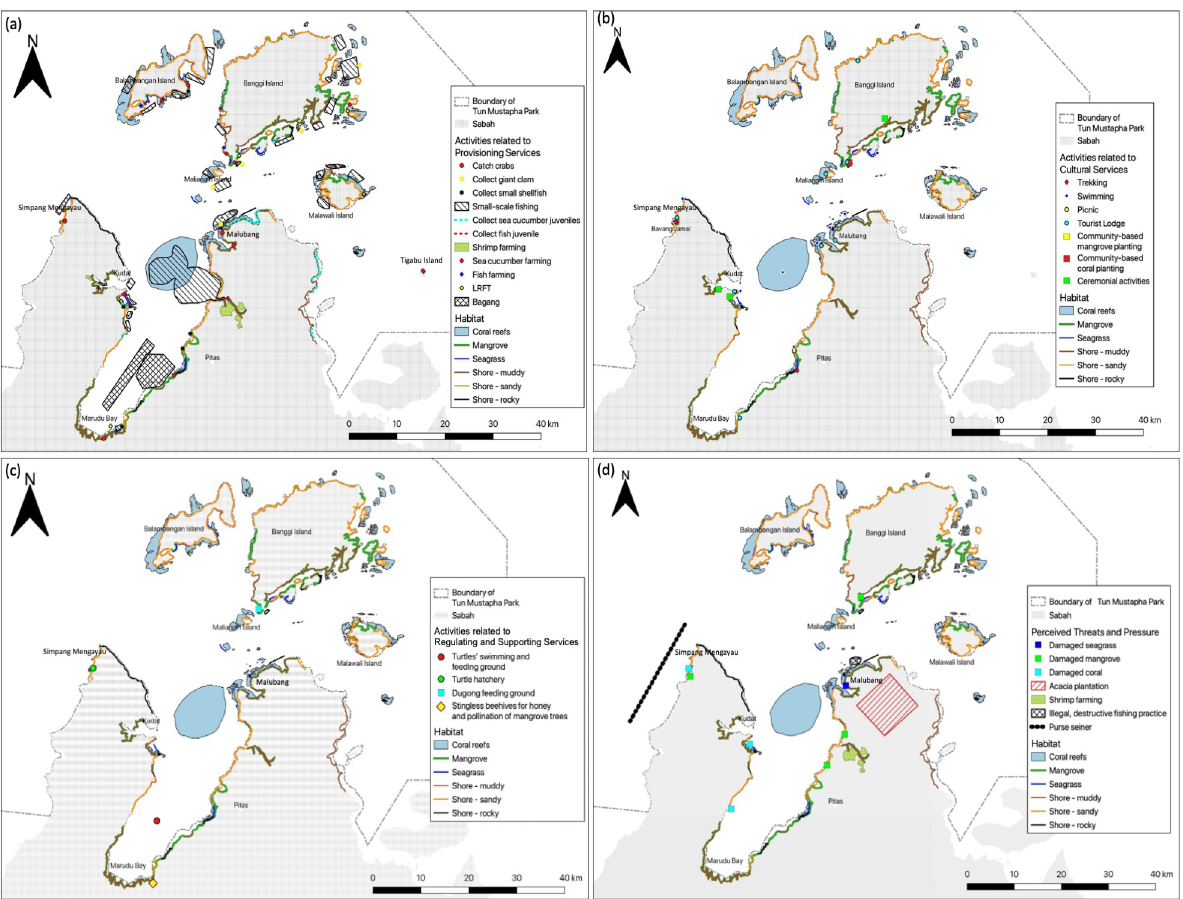
Fig 4. Digitised maps resulted from participatory mapping showing marine-associated habitats, ecosystem services and perceived threats in Tun Mustapha Park. (a) provisioning services. (b) cultural services. (c) regulating and supporting services. (d) perceived threats and pressures to the habitats and services. The information for each category of ecosystem service provided by the participants is considered as the benefits obtained from the marine ecosystem in TMP. The map was magnified to show the details. Note that there is a small island at the south of Maliangin Island called Maliangin Kecil Island which is surrounded by corals and seagrasses according to participants. LRFT stands for live reef fish trade. The map was created using QGIS 3.3.3, of which the distribution of coral reefs was referred to the public dataset by Ocean Data Viewer (https://data.unep-wcmc. org/datasets/1) and is for illustrative purposes